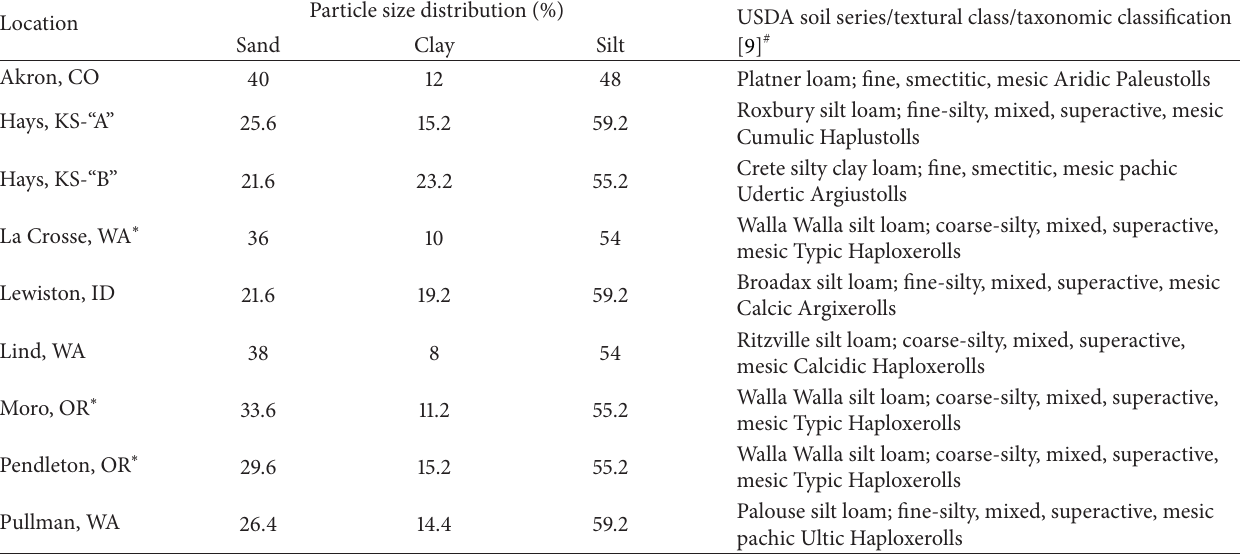
Table 2: Particle size distribution and USDA soil series, textural classes, and taxonomic classification of soils used in P. fluorescens D7rif survival